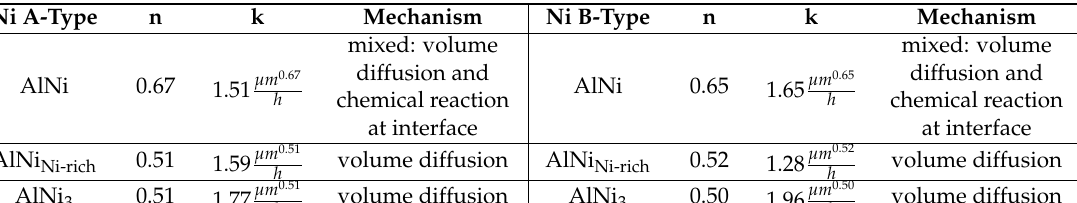
Table 6. The growth kinetics of AlNi, AlNi Ni-rich and AlNi 3 .